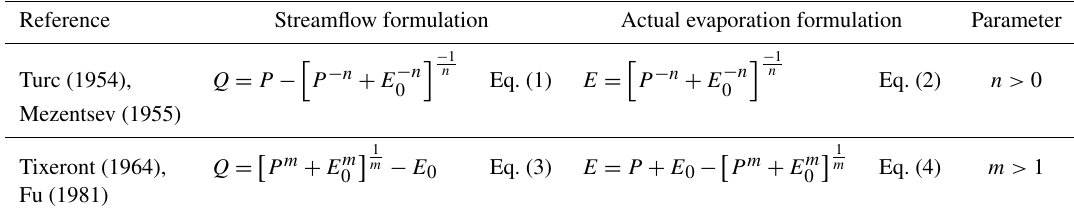
Table 1. Turc–Mezentsev (TM) and Tixeront–Fu (TF) water–energy balance formulations ( P – precipitation, Q – streamflow, E 0 – maximum evaporation, E – actual evaporation, all in mmyr − 1 averaged over many years). n is the free parameter of the Turc–Mezentsev formula ( n > 0); m is the free parameter of the Tixeront–Fu formula ( m > 1).